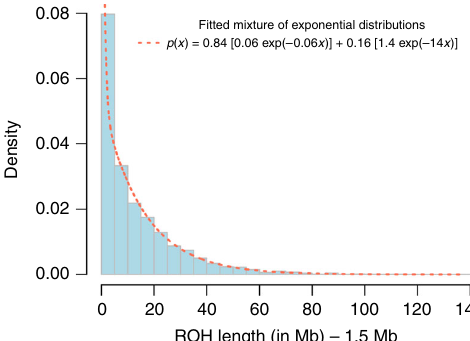
Fig. 2 Histogram of the lengths of 4,196 runs of homozygosity (ROHs) detected in 125 EI cases ( F ROH > 0.1). Each length was subtracted 1.5 Mb (i.e., minimum length used to detect ROHs) before mixture distribution was fi tted. A 84:16 mixture of two exponential distributions with means ~15.7 Mb (rate = 1/15.7 ~0.06) and ~0.72 Mb (rate = 1/0.72 ~1.4), respectively was found to best fi t the observed length distribution